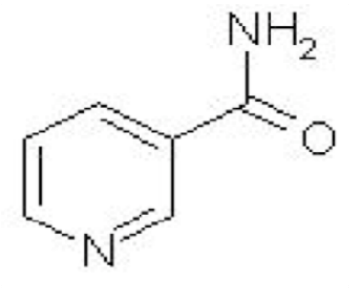
Figure 1. Chemical structures of nicotinamide and nicotinic